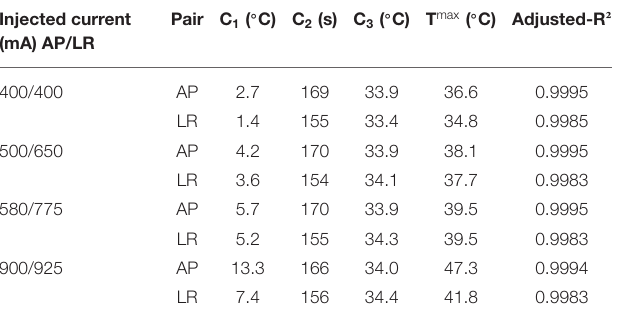
TABLE 4 | Amount of current injected into each pair and each layout to induce a maximum steady-state temperature of 39.5 ◦ C on the scalp, or as close as possible to it, underneath both pairs